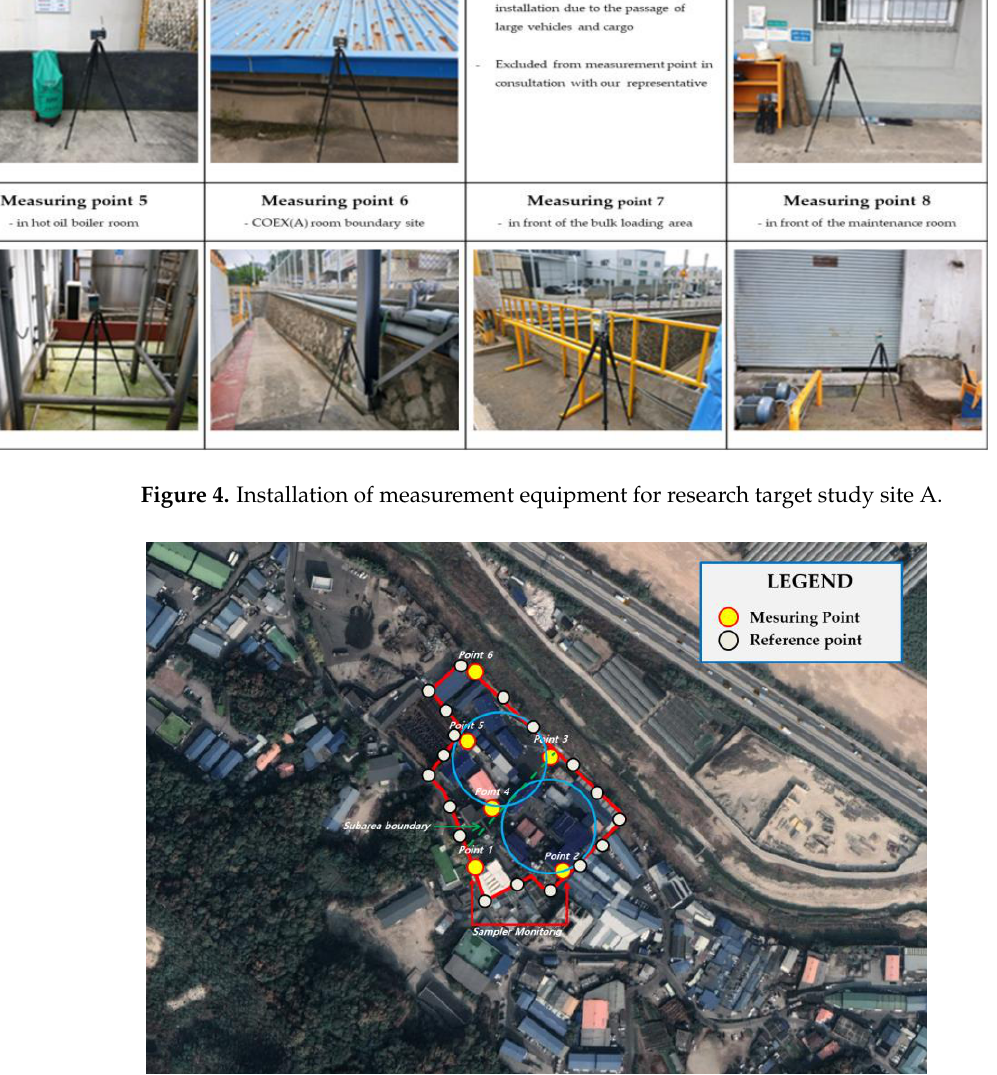
Figure 3. Measurement location of study site A.